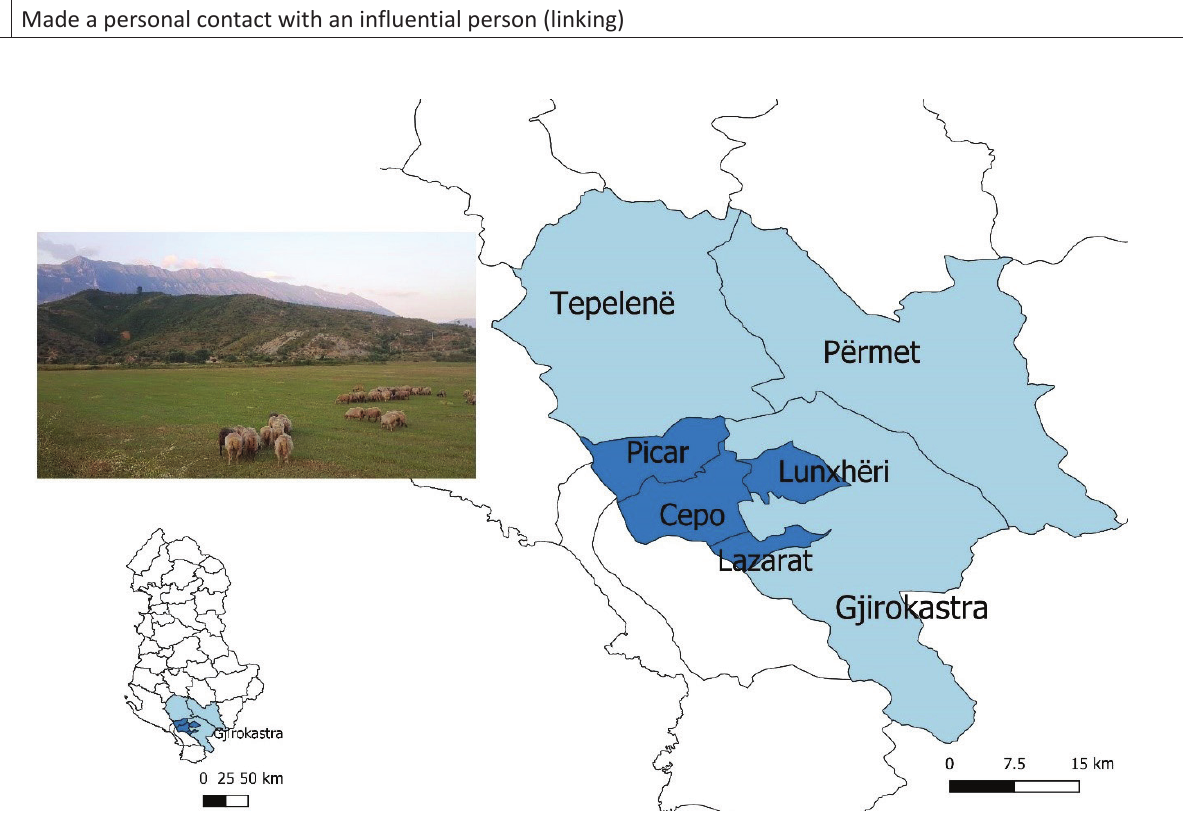
Figure 1. Geographical location of the study area within the Albanian